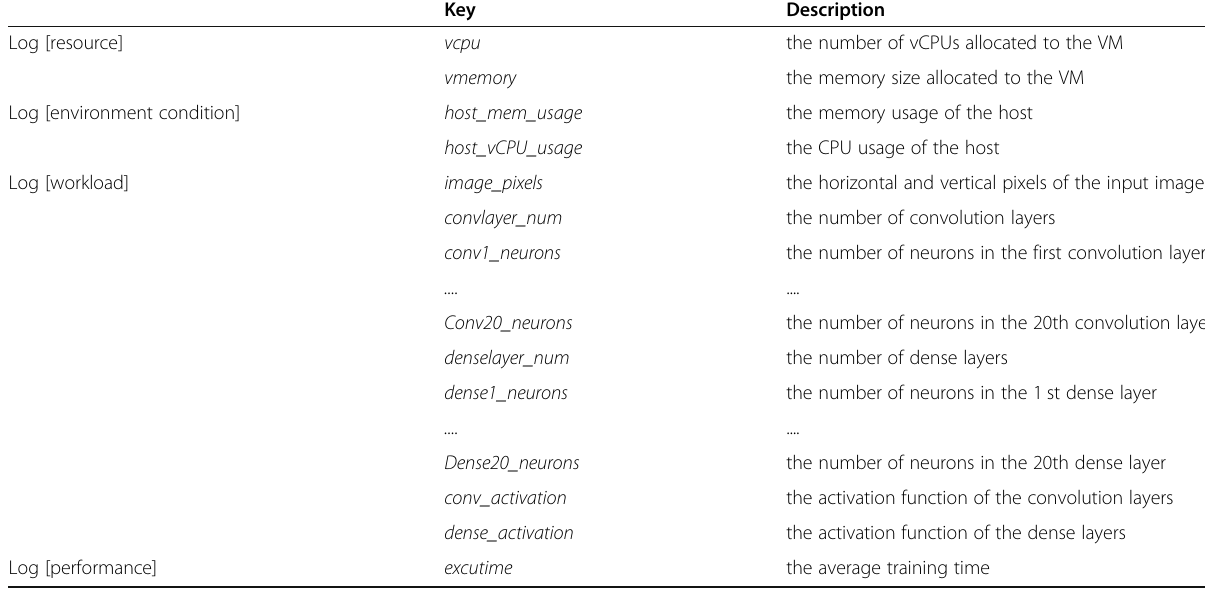
Table 6 Keys and descriptions of collected log data, i.e. training data for RDF models